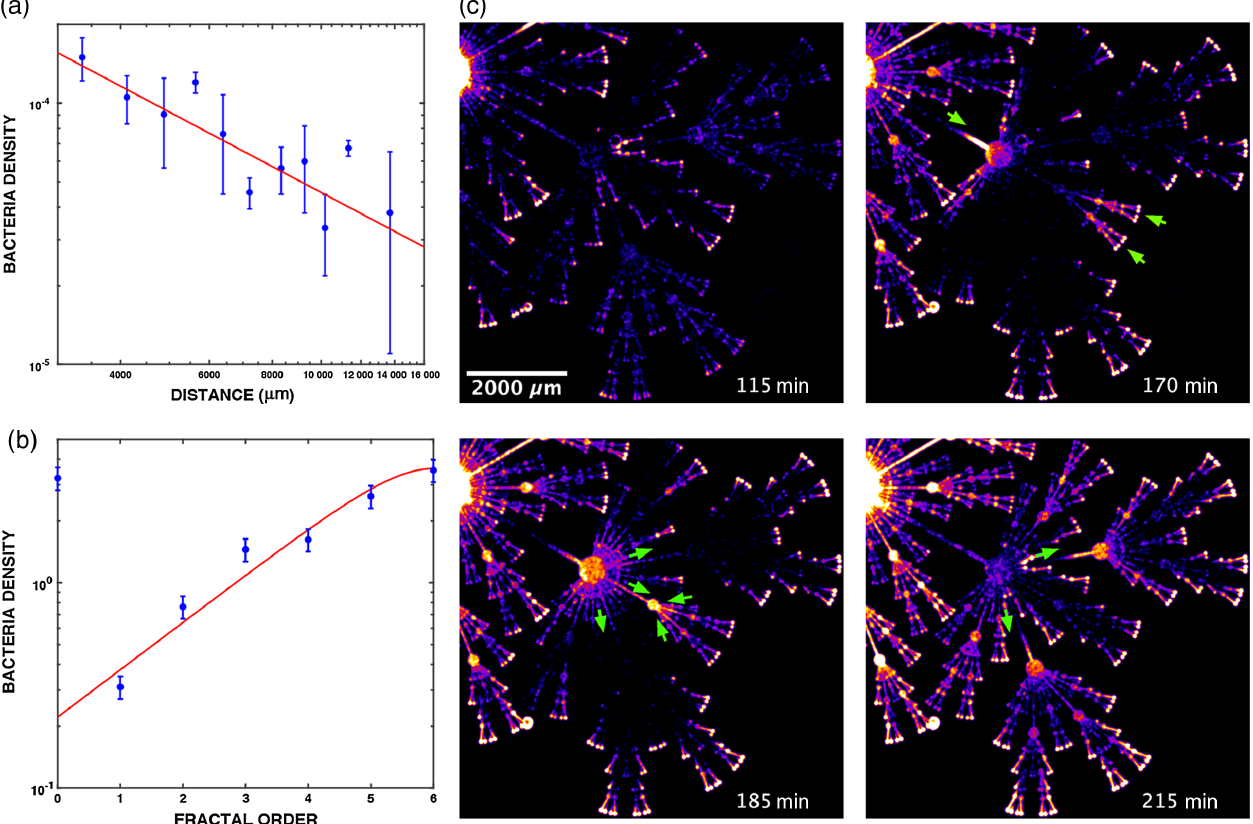
FIG. 6. (a) Bacterial density (in unit of 8 × 10 8 cells = mL) vs distance from the inoculation port at t ¼ 45 min after inoculation. The red line is a fit to power law. (b) Bacterial density (in unit of 8 × 10 8 cells = mL) from inoculation port to furthest fractal level at t ¼ 240 min from inoculation showing population inversion due to fractal pumping. The red line is a fit to theoretical model using PKS equations (see Appendix C). (c) Image sequence of colliding collective waves scattering into adjacent fractal leaves. Green arrows display the incident and scattering